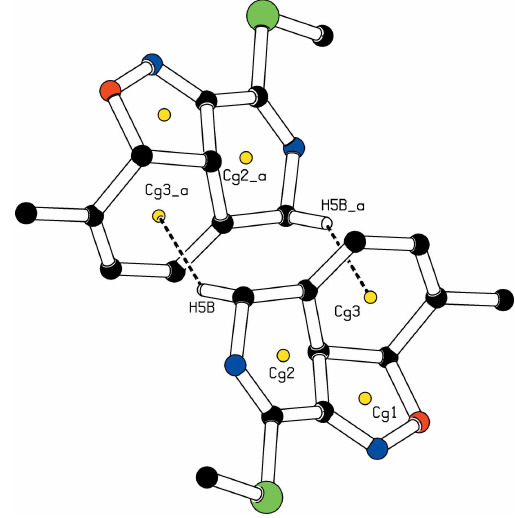
Figure 1 The molecular structure of the title compound and the atomic numbering scheme. Displacement ellipsoids are drawn at the 50% probability level. H atoms are shown as spheres of arbitrary